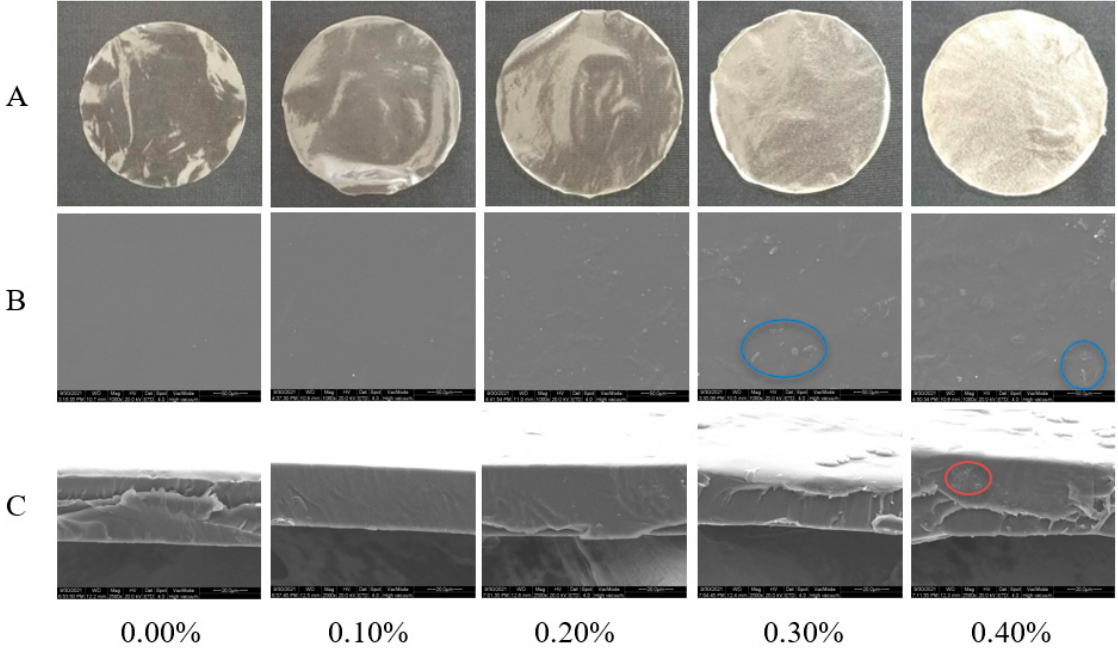
Figure 3. Photographs ( A ), micrographs of surface ( B ) and micrographs of cross section ( C ) of films with different SDF contents. The blue circle marks the graininess of the film surface. The red circle marks the pores in the cross section of the film.